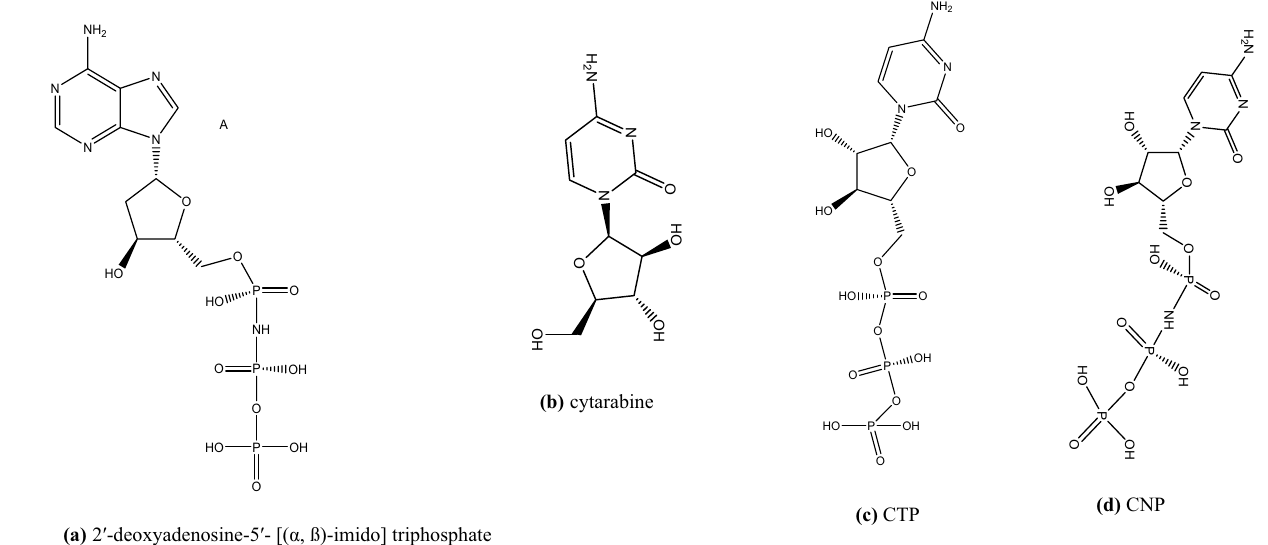
Figure 2. ( a ) 2 ′ -deoxyadenosine-5 ′ - [(α, ß)-imido] triphosphate, ( b ) cytarabine, ( c ) CTP, and ( d )